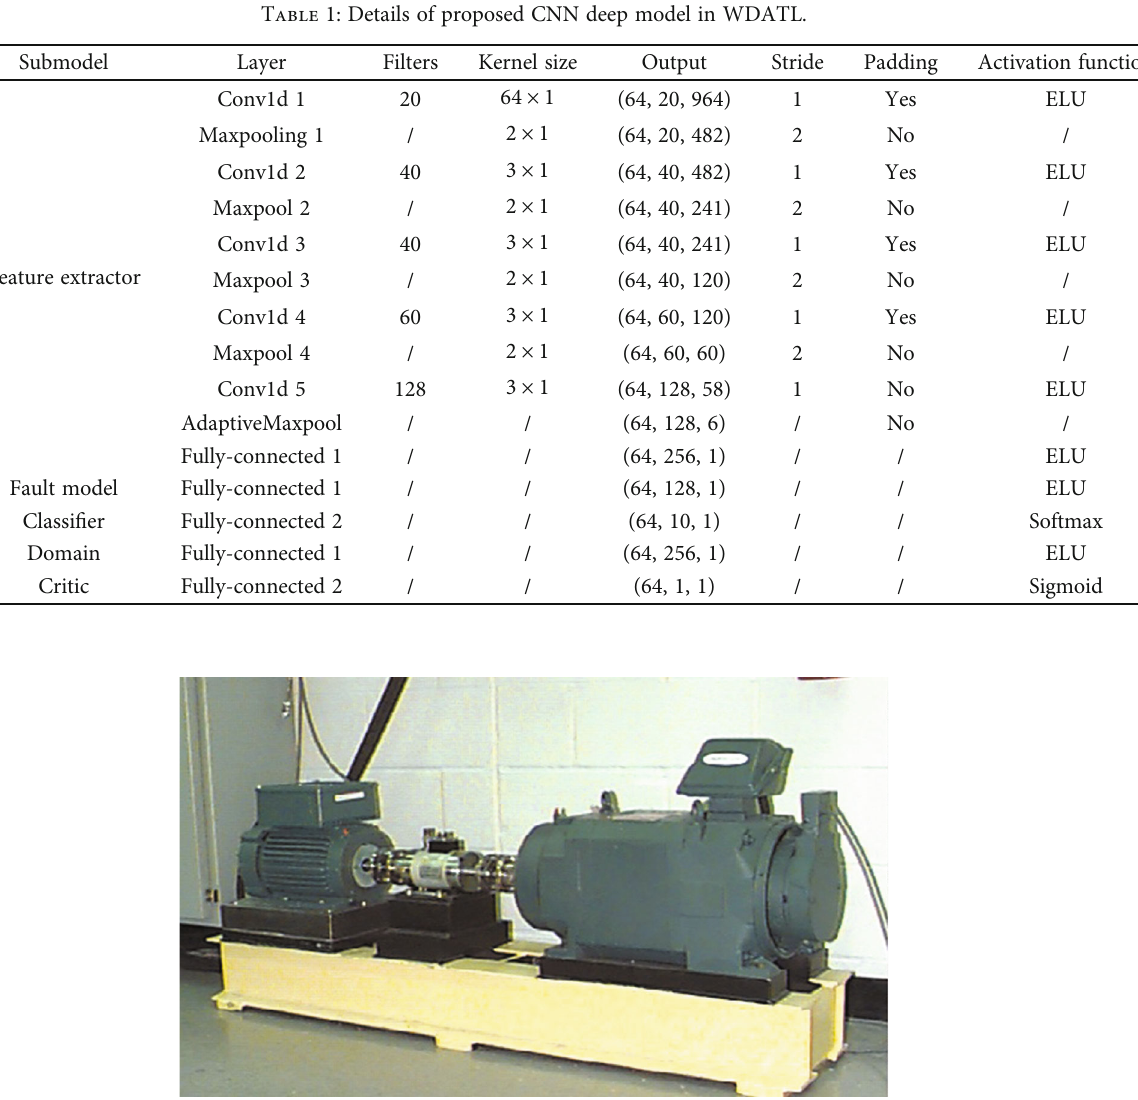
Figure 6: The test rig of CWRU.